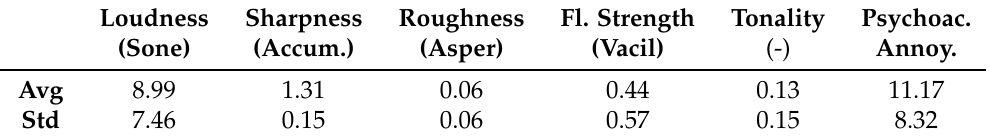
Table 8. Average and standard deviation values of the computed psychoacoustic parameters for the auralization of the bailiff sound source in the environment of the Water Tribunal.